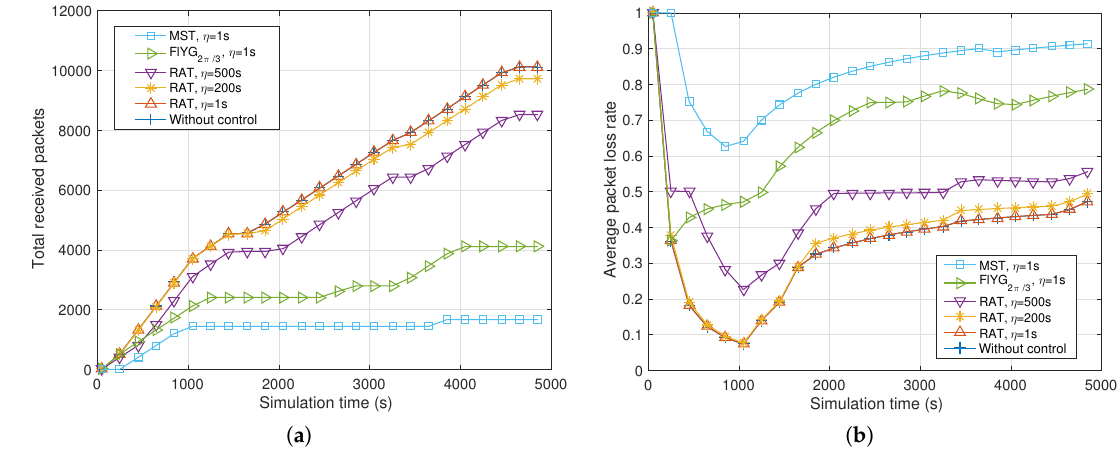
Figure 9. Results from three topology control algorithms (RAT, FlYG 2 π /3 , MST) showing total received packets ( a ) and average packet loss rate ( b